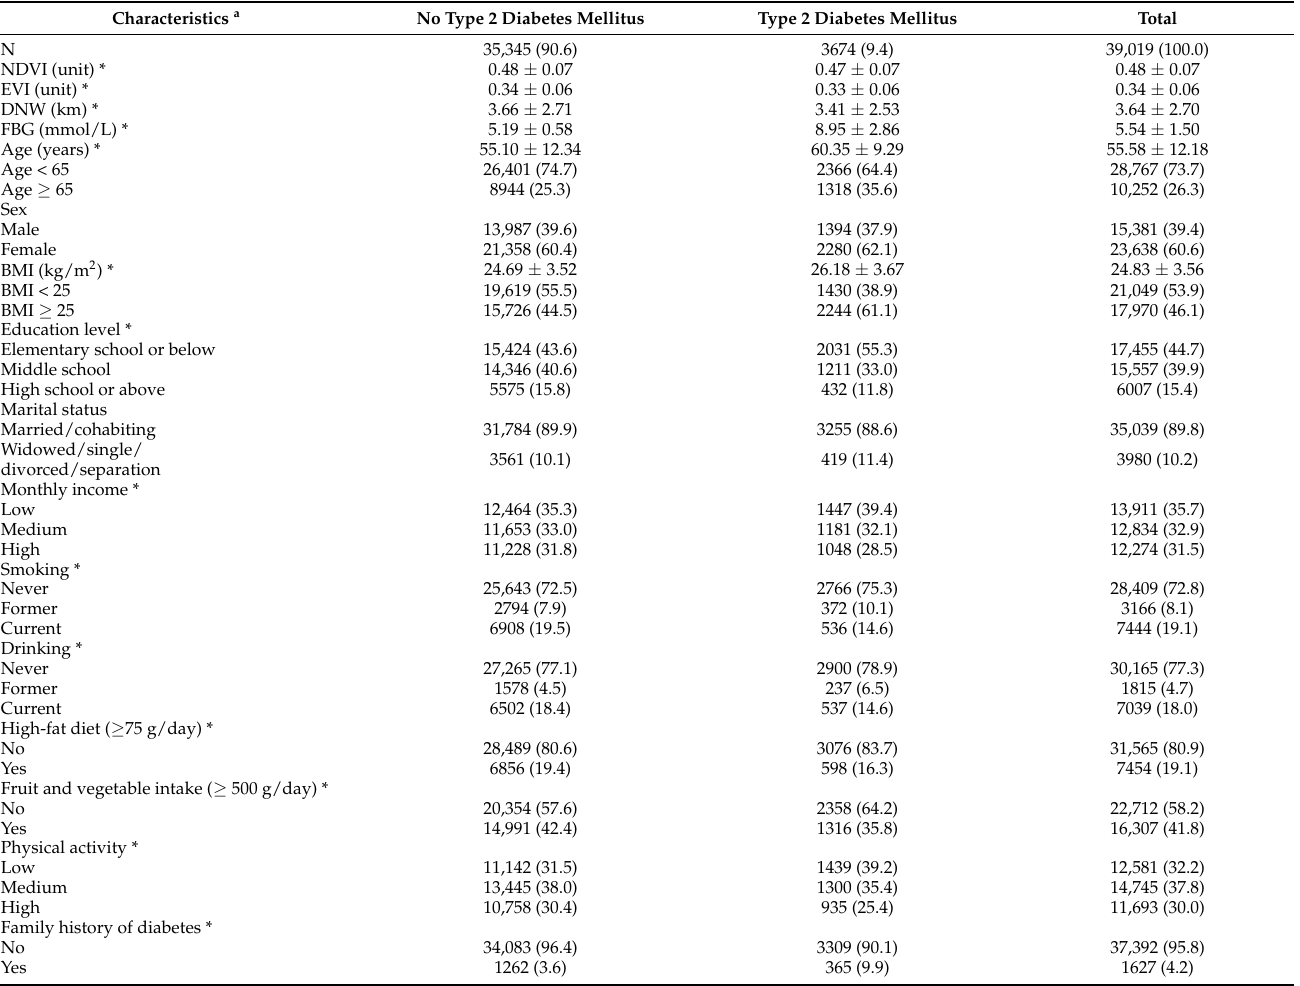
Table 1. Basic characteristics of study